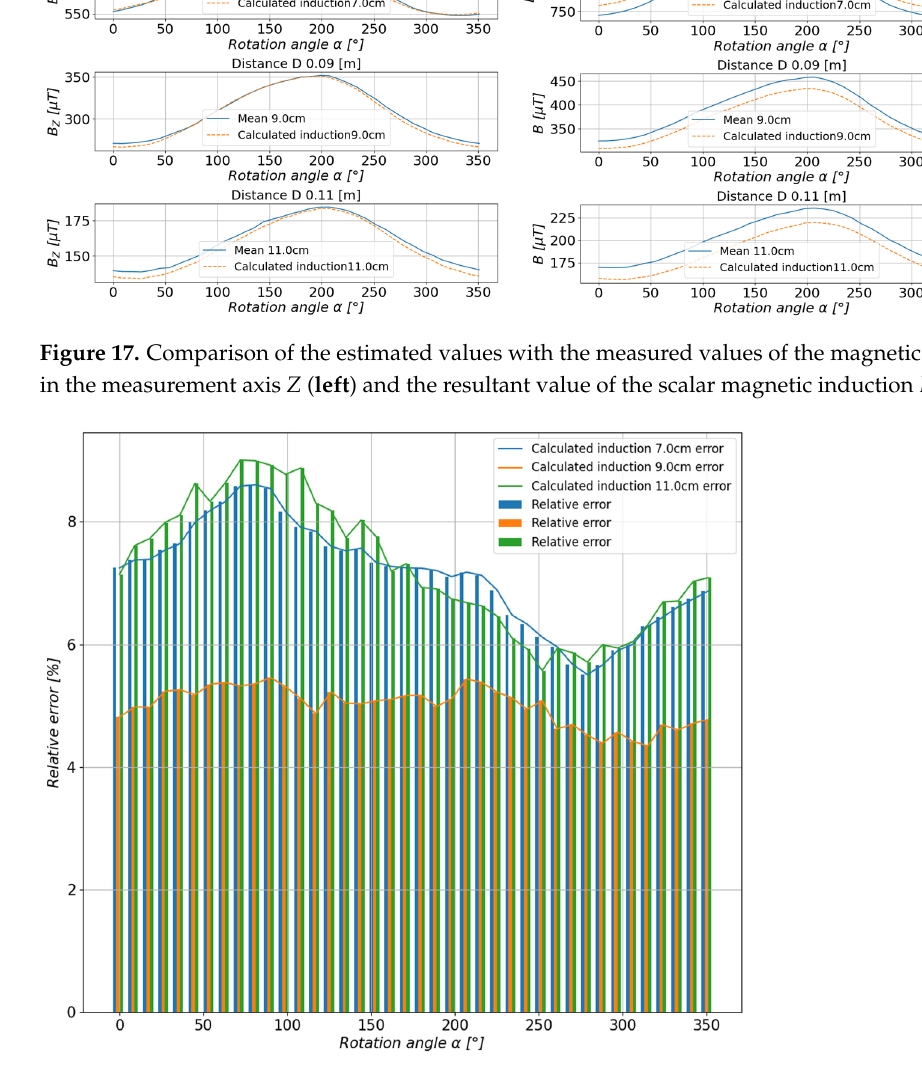
Figure 18. Comparison of the relative errors for the estimated values of the magnetic induction of the tested toroidal magnet depending on the measuring distance.